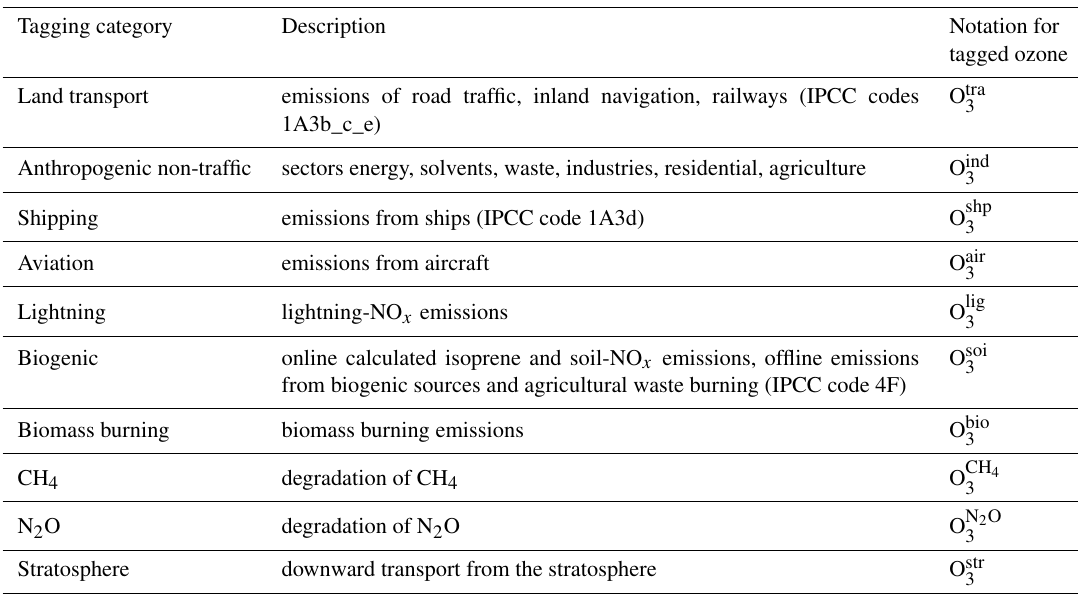
Table 3. Description of the different tagging categories applied in this study following Grewe et al. (2017). Please note that some tagging categories summarize different emission sectors (see description). The last row shows the nomenclature of the tagged tracers for ozone as an example.